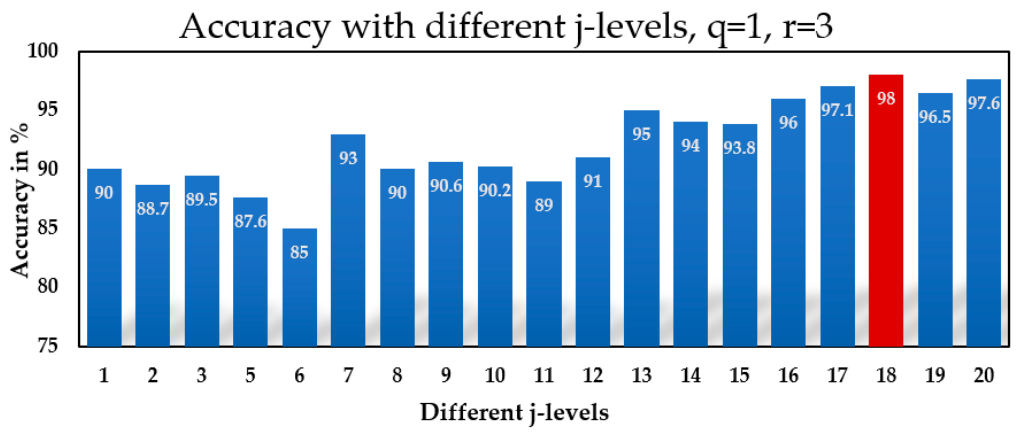
Figure 15. Accuracy with different j-level q = 1, r = 3.